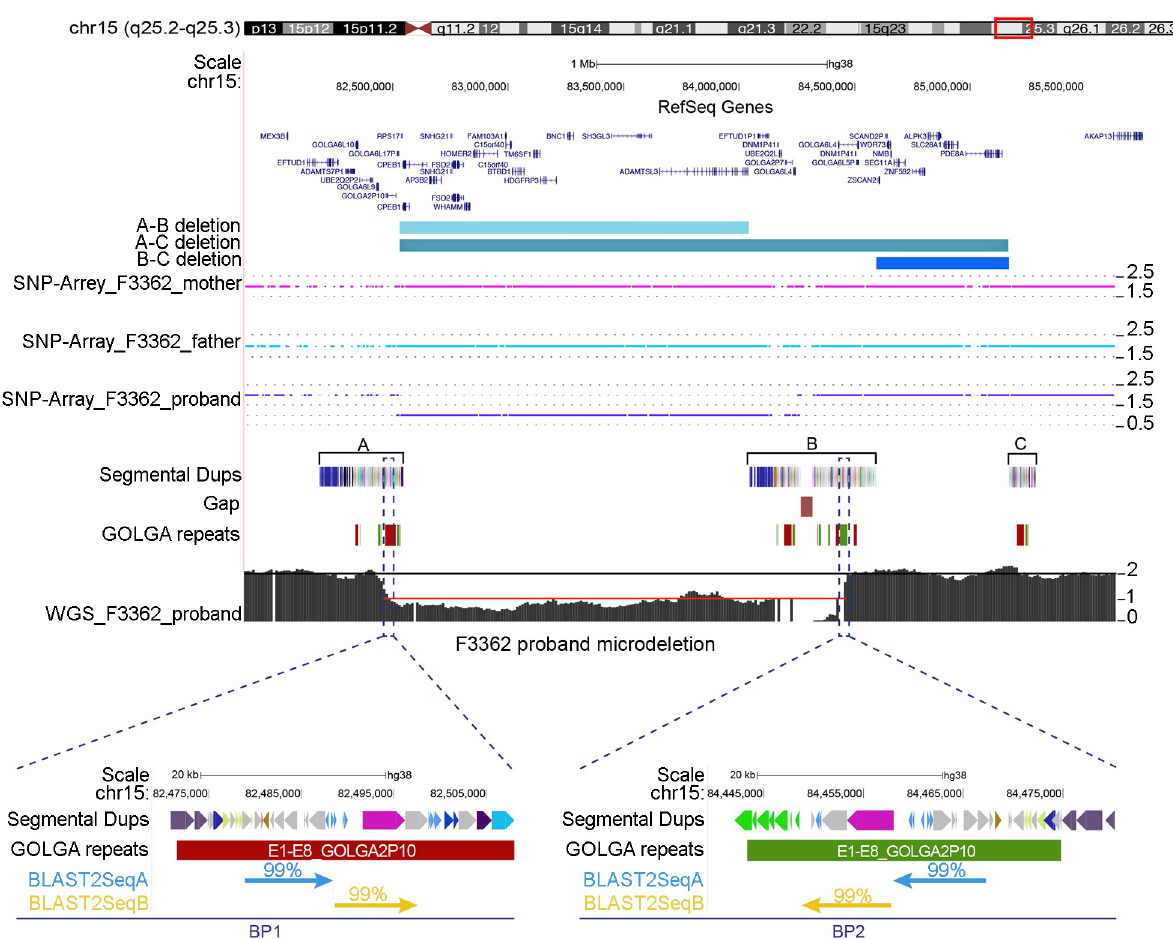
Fig 4. Deletions at the 15q25 region. Three different classes of microdeletions with breakpoints between segmental duplication blocks A-B, A-C and B-C are shown as colored boxes. Segmental duplications are shown with colored boxes. GOLGA repeat locations from the blat analysis of GOLGA2P10 and GOLGA6L5P are depicted with green and red boxes mapping on plus or minus strand, respectively. SNP array and whole-genome sequencing (WGS) data of a patient with a 15q25 A-B deletion are shown. The SNP array highlights a copy number (CN) of 2 for the parents while the proband shows a CN of 1 for the deleted region. WGS shows a CN of 2 for the regions flanking the microdeletion (black line) and a CN of 1 (red line) for the deleted region. At the bottom of the figure are shown the results of a blast2Seq alignment between the two microdeletion breakpoint intervals. The two largest alignments of 9.4 kbp (blast2SeqA) and 9 kbp (blast2SeqB) with 99% similarity are shown with light blue and yellow arrows, respectively. GOLGA2P10 repeats, which encompass the regions of high similarity at the breakpoints, are also shown in the zoom